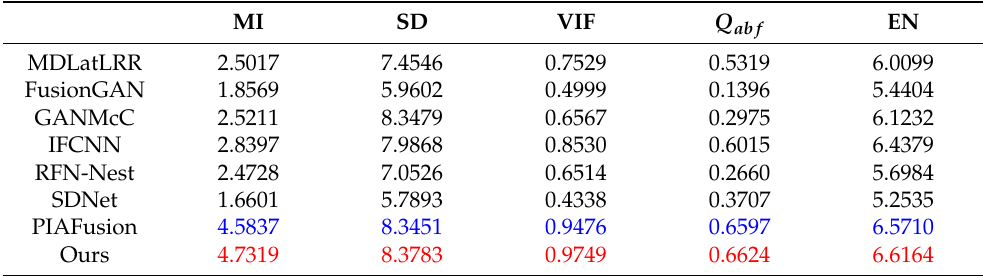
Table 4. The results of different metrics for the eight algorithms on the 361 MSRS dataset. The red value indicates the best result and the blue value indicates the second best